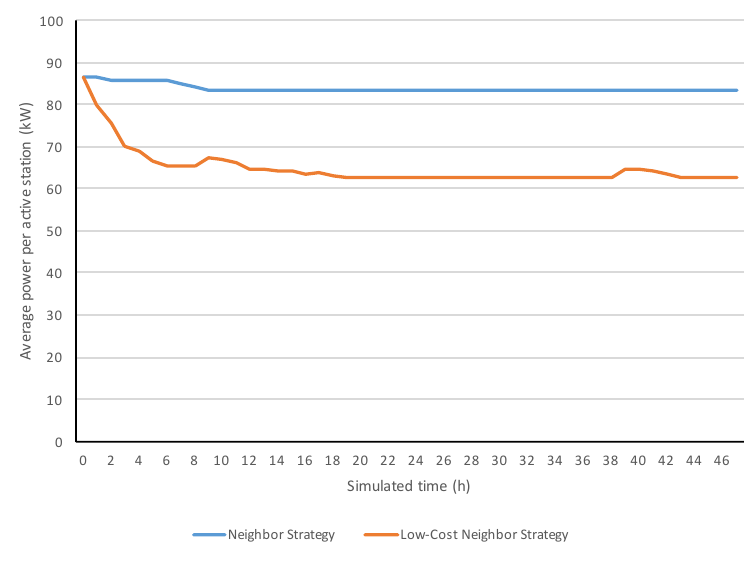
Figure 6. Simulation evolutions of the average power per active station.